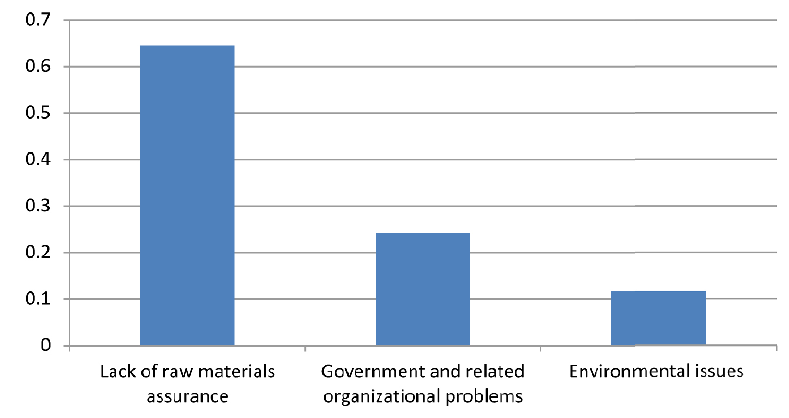
Figure 6: The priority of risks indices in first level (inconsistency rate 0.02), X: Criteria, Y: Weighing